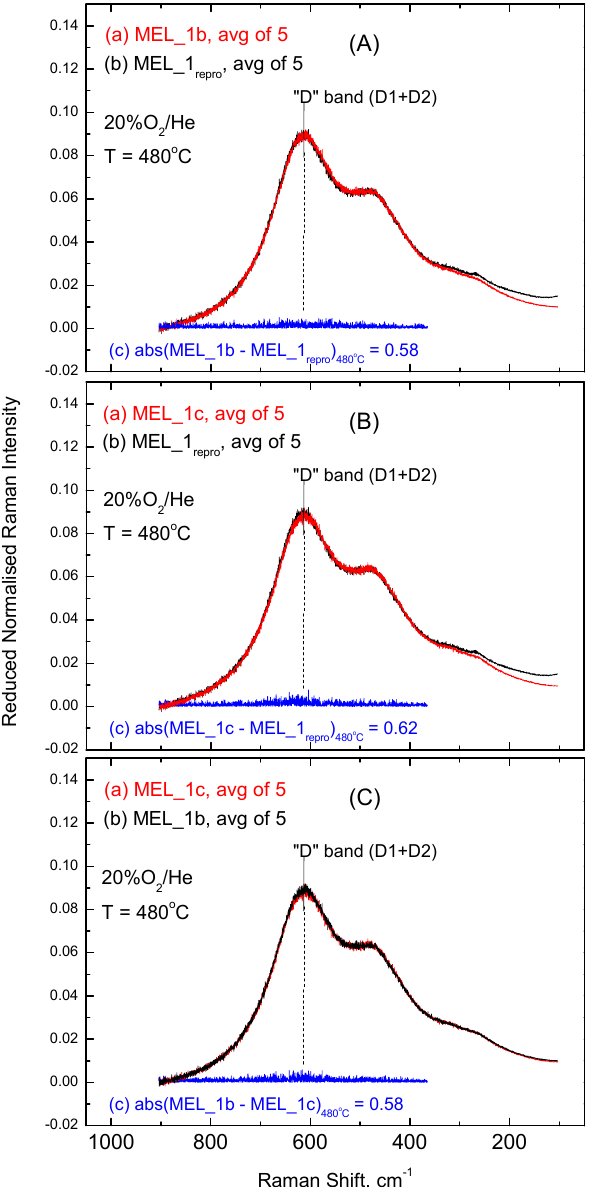
Figure 4. Inter-batch comparison of reduced and normalized in situ Raman spectra obtained for specimens of MEL_1 material from three di ff erent industrial lots under 20% O 2 / He at 480 ◦ C. ( A ) MEL_1 vs. MEL_1b; ( B ) MEL_1 vs. MEL_1c; ( C ) MEL_1b vs. MEL_1c. All traces shown are the averages of five recordings. Traces (c) with blue color in panels ( A – C ) show the absolute di ff erence of the spectra under comparison in each case. The 0.58, 0.62, and 0.58 values correspond to the integrals under each trace